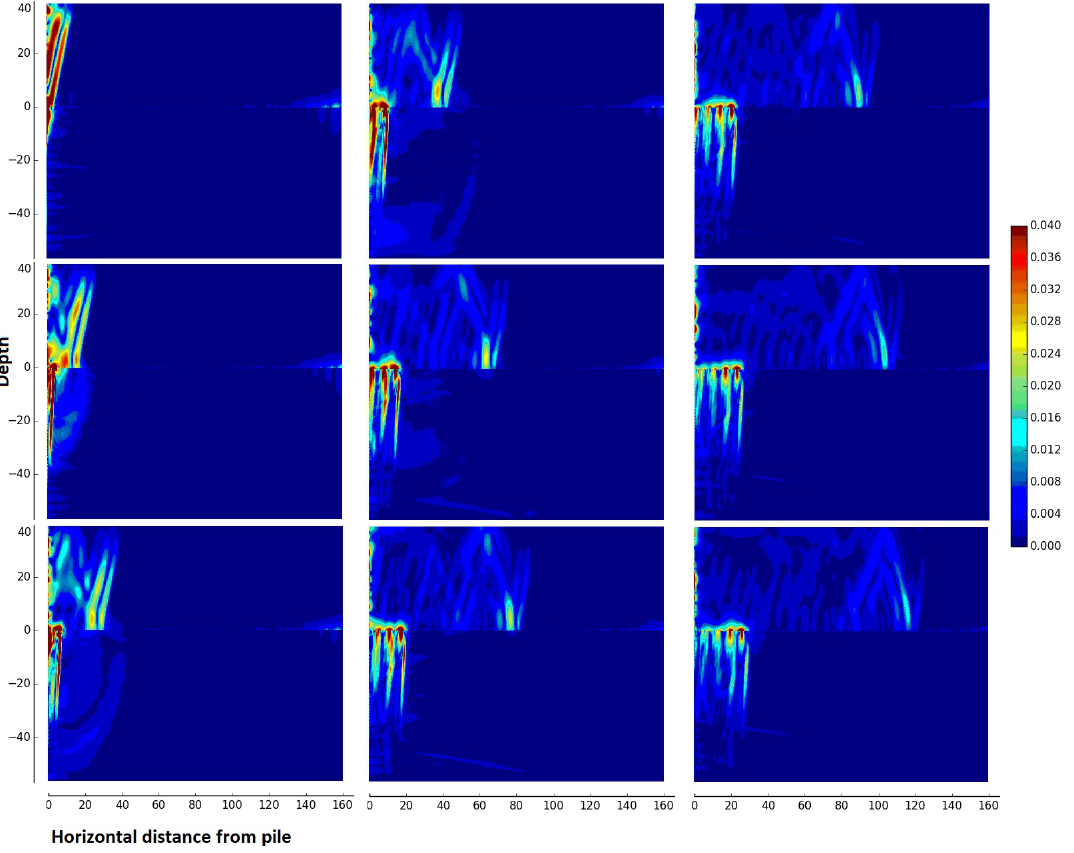
Figure 4. Evolution of the particle velocity norm in the seawater ( z ≥ 0 m) and the seabed ( z < 0 m) for several moments in time after the hammer impact using the model by Tsouvalas and Metrikine [115]. In the case analysed, the pile has a diameter of 7 m and a length of 78 m and the seabed consists of a soft upper soil layer overlying a stiffer soil halfspace. The time increases from top to bottom and from left to